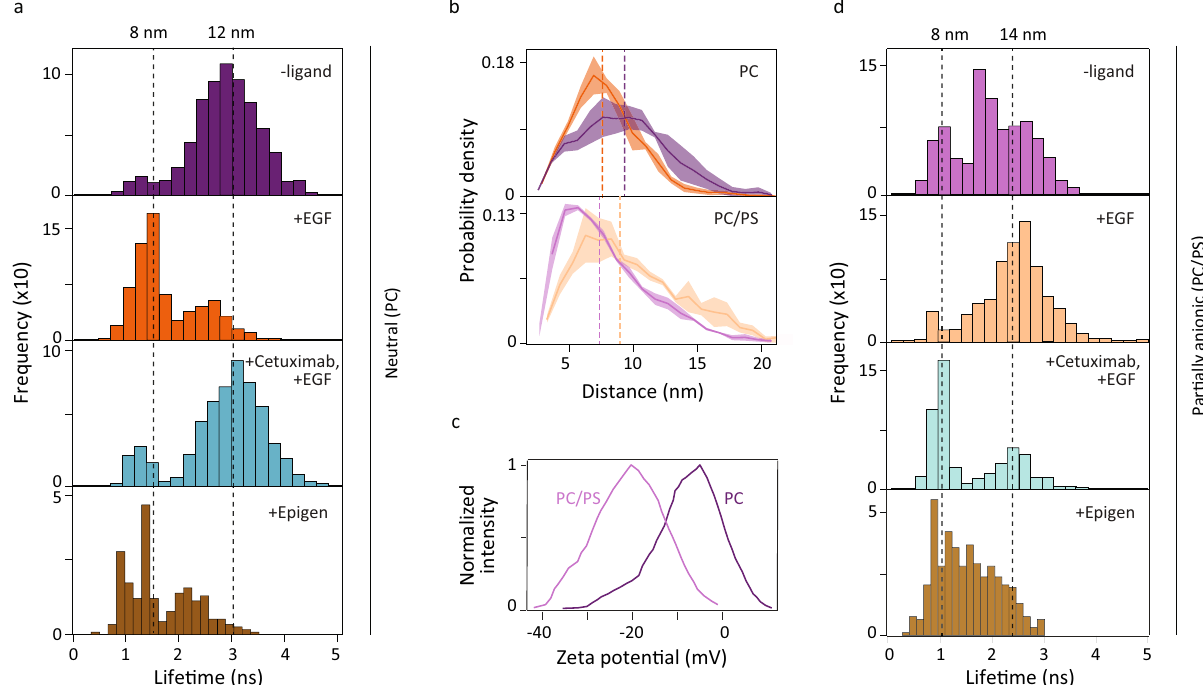
Fig. 2 smFRET and MD simulations reveal extracellular/intracellular conformational coupling in EGFR. smFRET measurements ( a , d ) were used to build histograms of the donor lifetime, which shortens as the donor-acceptor distance decreases. Dotted lines indicate the medians with corresponding distances on upper x-axis. a The donor fl uorescence lifetime distribution in DMPC (PC) bilayer without ligand (top); with 1 μ M EGF (second); with 1 μ M EGF and 100 nM Cetuximab (third); with 1 μ M epigen (bottom). b Molecular dynamics trajectories were used to fi nd the probability density distribution of the vertical separation in a PC bilayer (top) or a POPC-POPS (PC/PS) bilayer (bottom) without EGF (purple) and with EGF (orange). Dotted lines indicate the median of the distributions (PC bilayer: 9.2 nm (-EGF) and 7.5 nm ( + EGF); PC/PS bilayer: 7.4 nm ( − EGF) and 9.0 nm ( + EGF)). The shaded regions represent the standard deviation estimated with block averaging. c Zeta potential distributions for EGFR in PC (dark purple) and PC/PS (light purple) nanodiscs. d The donor fl uorescence lifetime distribution in PC/PS bilayer without ligand (top); with 1 μ M EGF (second); with 1 μ M EGF and 100 nM Cetuximab (third); with 1 μ M epigen (bottom). Source data are provided as a Source data fi